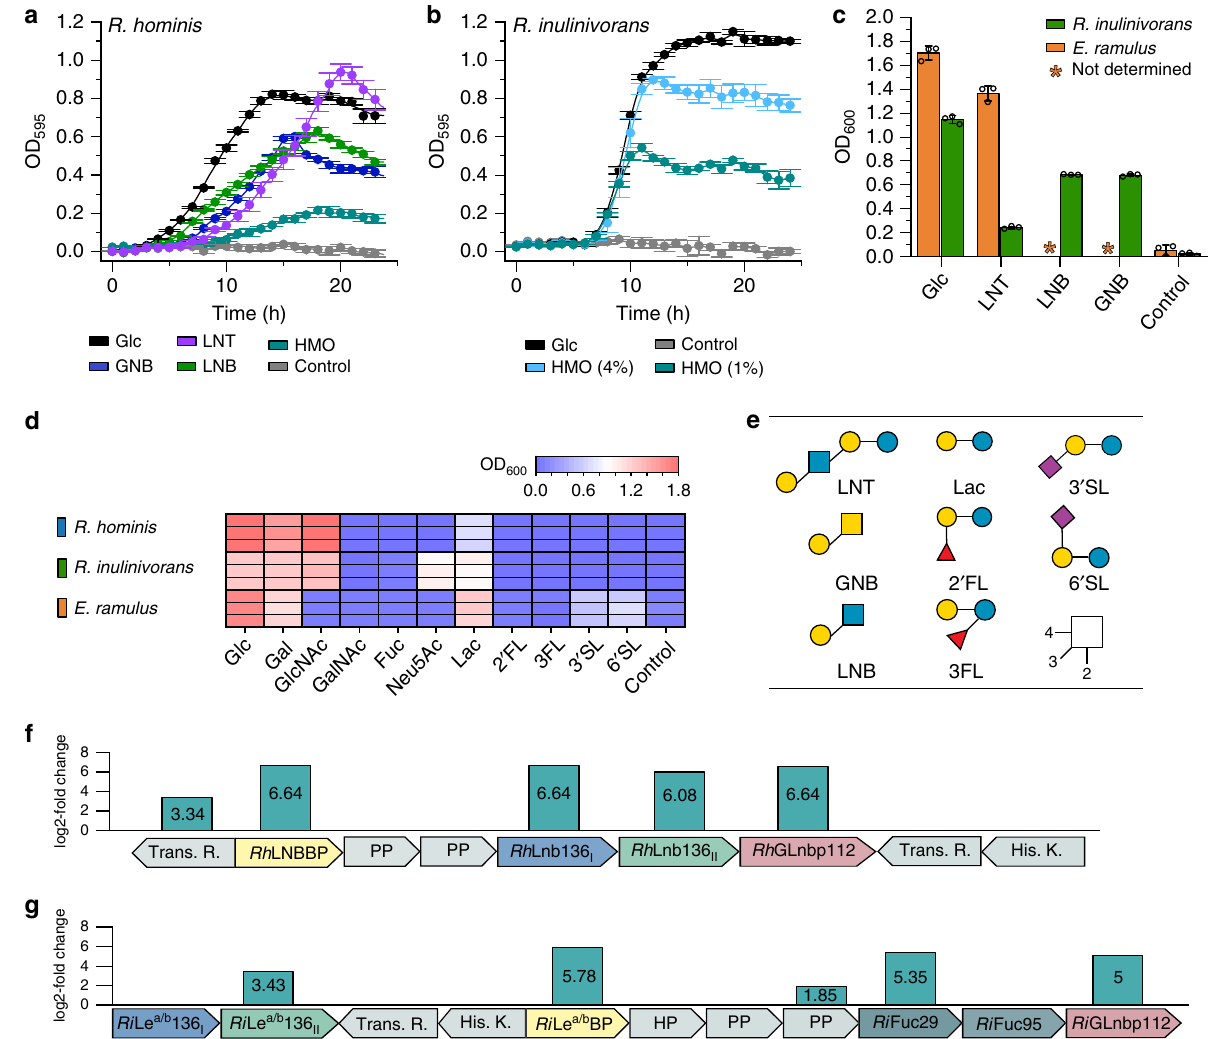
Fig. 1 Growth of Roseburia and Eubacterium spp. on HMOs and upregulation of HMOs utilization loci in Roseburia . Growth curves of R. hominis ( a ) and R. inulinivorans ( b ) on glucose, LNT, GNB, LNB, and/or puri fi ed HMOs from mother ’ s milk compared to no-carbon source controls over 24 h. c Growth levels of R. inulinivorans on LNT, LNB, GNB and of E. ramulus on LNT within 24 h including glucose and a no-carbon source controls. d , Growth of R. hominis , R. inulinivorans and E. ramulus on lactose, 2 ′ FL, 3FL, 3 ′ SL and 6 ′ SL as well as on monosaccharides from HMOs and mucin after 24 h including a non-carbon source control. Growth analyses ( a – d ) on media supplemented with 0.5 % (w/v) carbohydrates (for R. inulinivorans on 1% (w/v) and 4% (w/v) puri fi ed HMOs from mothers milk) were performed in independent biological triplicates. The growth data are presented as mean values with the error bars representing the standard deviations (SD) for a – c . e HMO and mucin oligomeric growth substrates in a – d . The HMO utilization loci in R. hominis ( f ) and R. inulinivorans ( g ) identi fi ed from proteomic analyses of cells growing on LNT and HMOs from mother ’ s milk, respectively, relative to glucose. Genes are denoted by their protein products: transcriptional regulator (Trans. R.); ABC transporter solute binding protein ( Rh LNBBP ( f ) and Ri Le a/b BP ( g )); ABC transporter permease protein (PP); hypothetical proteins (HP); Glycoside hydrolase 136 ( Rh Lnb136 I , Rh Lnb136 II ( f ) and Ri Le a/b 136 I , Ri Le a/b 136 II ( g )); Glycoside hydrolase 112 ( Rh GLnbp112 ( f ) and Ri GLnbp112 ( g )); Glycoside hydrolase 29 ( Ri Fuc29 ( g )); Glycoside hydrolase 95 ( Ri Fuc95 ( g )) and histidine kinase sensory protein (His. K.) The proteomic analyses ( f – g ) were in biological triplicates and the log 2 -fold change from the label free quanti fi cation of upregulated gene products is shown. Glycan structures presentation according to Symbol Nomenclature for Glycans (SNFG) (https://www.ncbi.nlm.nih. gov/glycans/snfg.html). Source data are provided as a Source data fi le labelled with the corresponding fi gure number and panel de fi